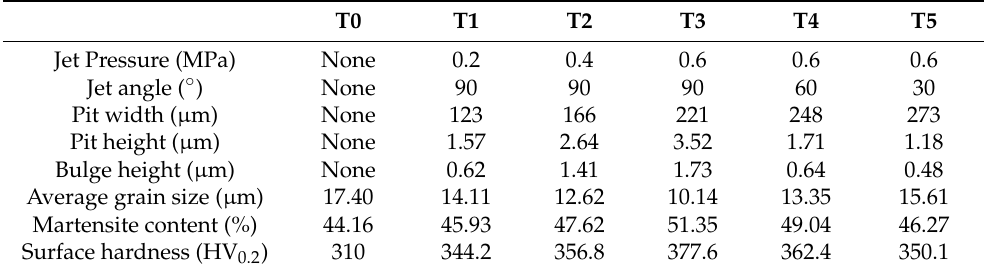
Table 4. Summary of test results at different jet pressures and